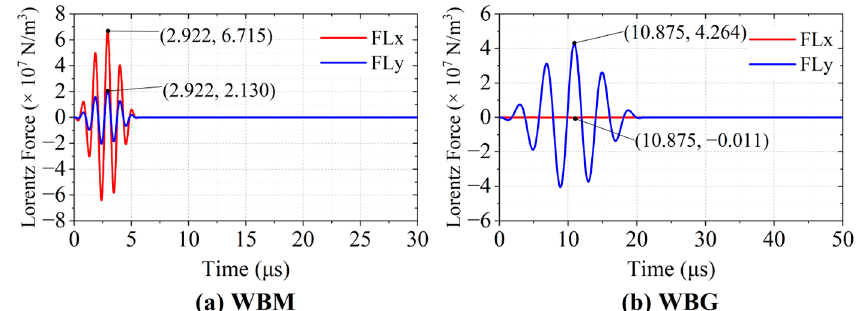
Figure 9. Lorentz forces at P0 of the WBM and WBG models.